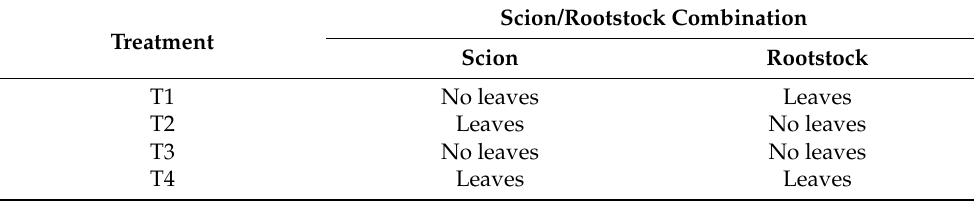
Table 1. Grafting treatment combinations performed in Trial 1.